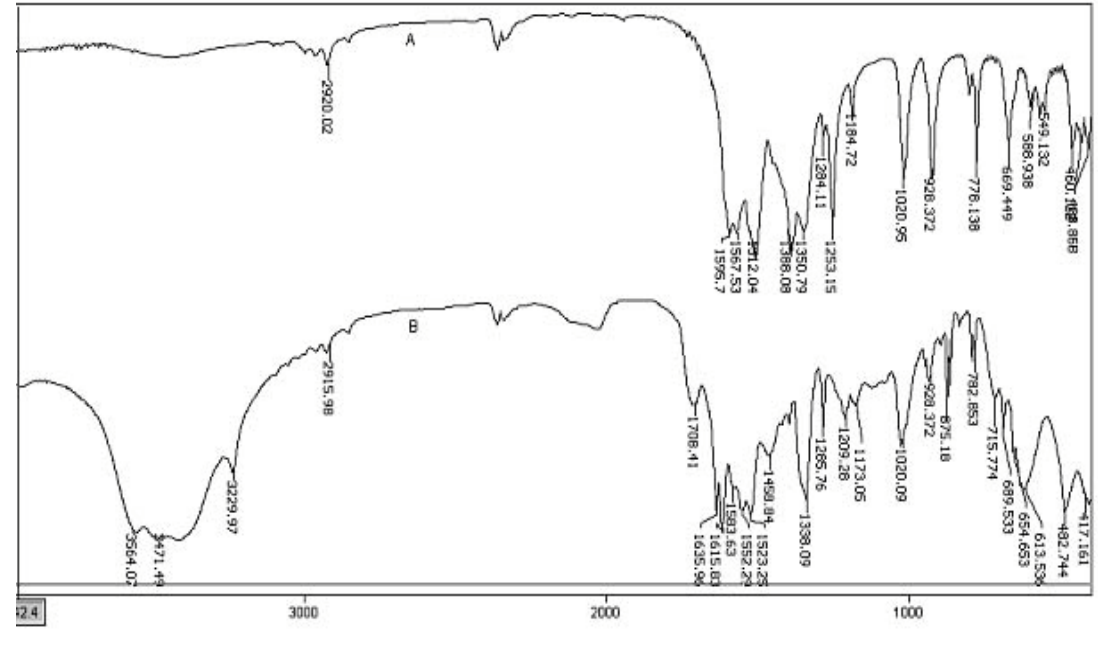
Figure 1. Comparative FTIR spectra: A) the complex of Mn(III)-acetylacetone, B) the complex of